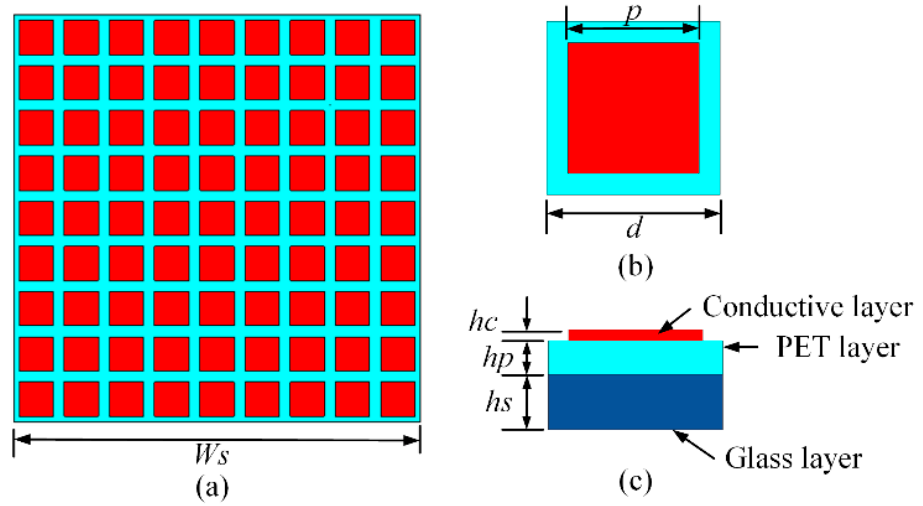
Figure 2. Proposed MS: ( a ) top view of MS, ( b ) top view of unit cell, and ( c ) side view of unit cell.